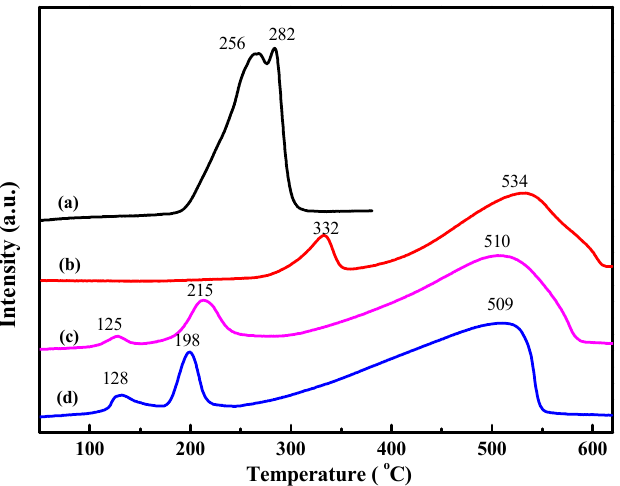
Figure 3. TPR profiles of ( a ) pure CuO, ( b ) pure Fe 2 O 3 nanorods, ( c ) CuFe19 ‐ R, and ( d ) CuFe ‐ P.